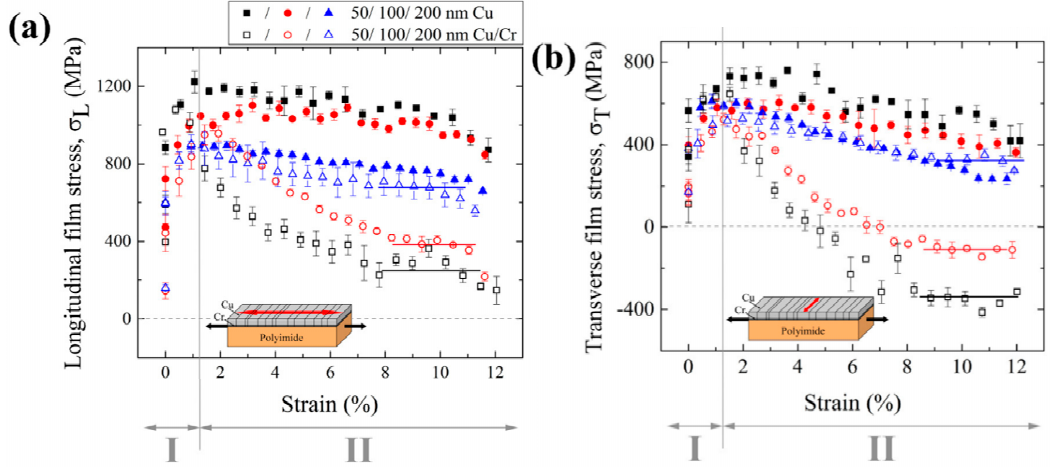
Figure 8. ( a ) Longitudinal film stresses, σ L , and ( b ) the transverse film stresses, σ T , in Cu films and in Cu layers of the Cu/Cr films with 50, 100, and 200 nm Cu layer thicknesses. The film stresses measured with the sin 2 φ method are plotted against the engineering strain, ε , determined by the tensile device. The results for Cu films are marked with full symbols and for the Cu/Cr films with open symbols. The first points of the curves correspond to the residual stresses measured before the tensile test. The inset diagrams show the tensile direction (black arrows) and the measuring direction of the film stresses (red arrow). The standard deviation is used to calculate the error bars. In order to guide the eye, the solid lines indicate the plateaus of the crack saturation region in the Cu/Cr films.